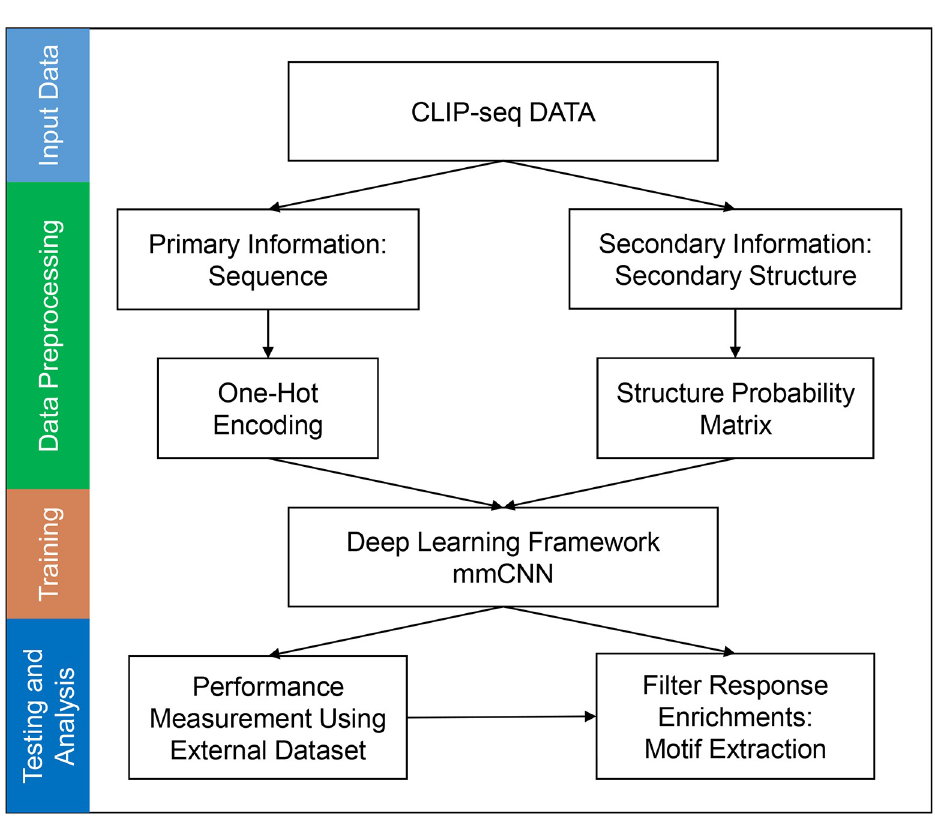
Fig 1. Overall summary of training procedure and performance measurement of mmCNN. Sequence data was transformed into one-hot encoded information and structure probability matrix using RNAshapes program. Bimodal information was integrated into combined representation and trained by mmCNN framework. During performance measurement, prediction of RBP binding site and its motif was predicted using external test dataset.